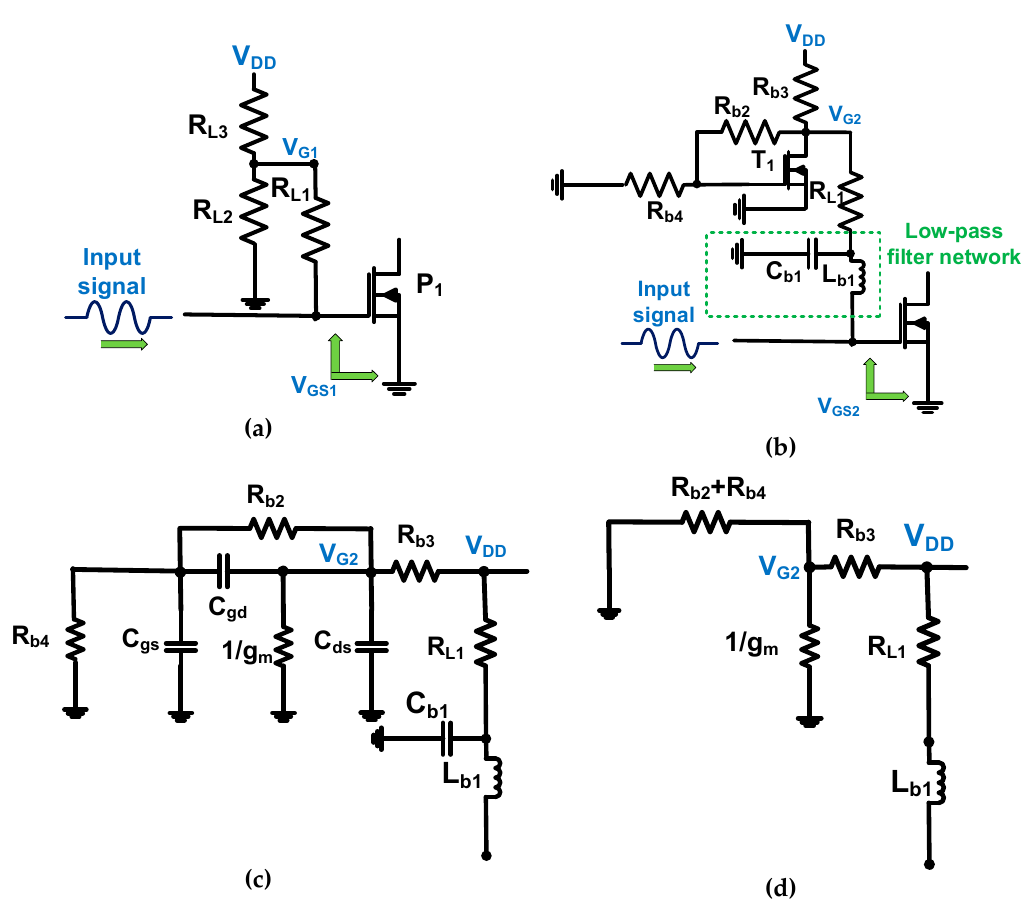
Figure 4. Schematic diagrams of ( a ) resistor divider network and ( b ) transistor linearizer network with main transistor (P 1 and P 2 ) of the class-C amplifiers. ( c ) Equivalent circuit model of the transistor linearizer network; ( d ) simplified equivalent circuit model of the transistor linearizer network without capacitors.